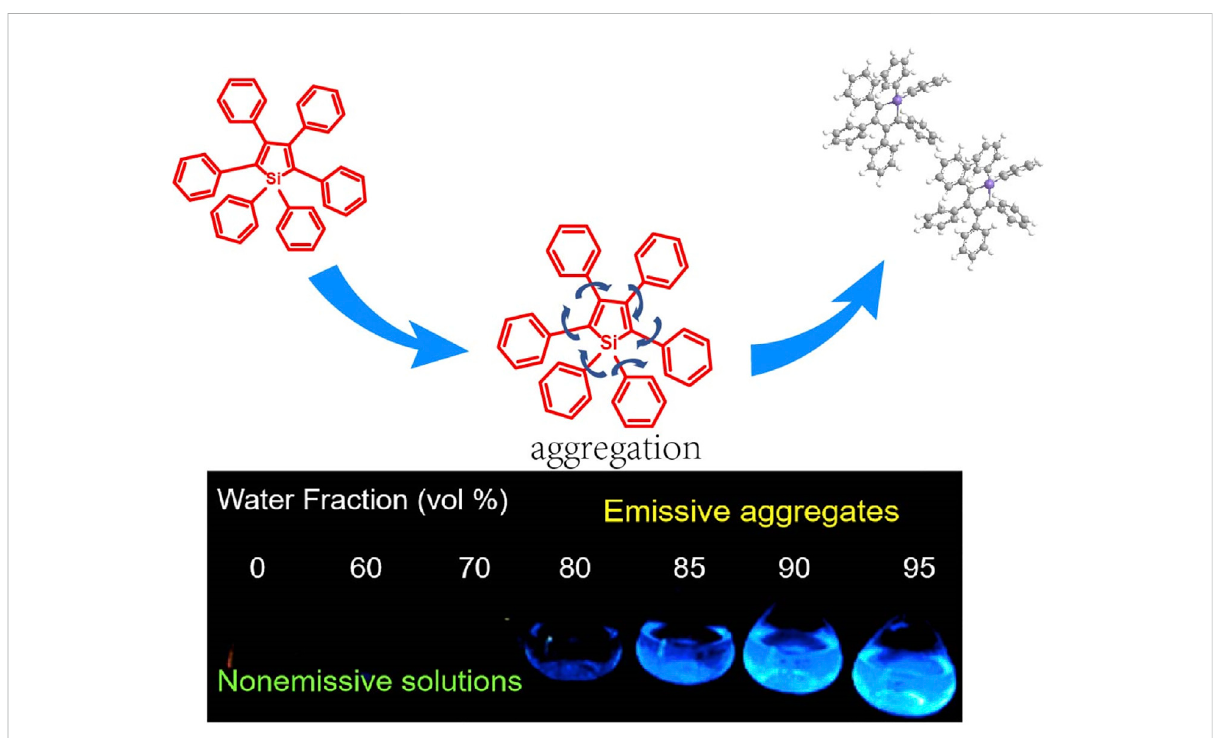
FIGURE 1 Aggregation-inducedemissioneffect: fl uorescencephotographsofsilole moleculesinTHF/watermixturesunderUVlight(Dong